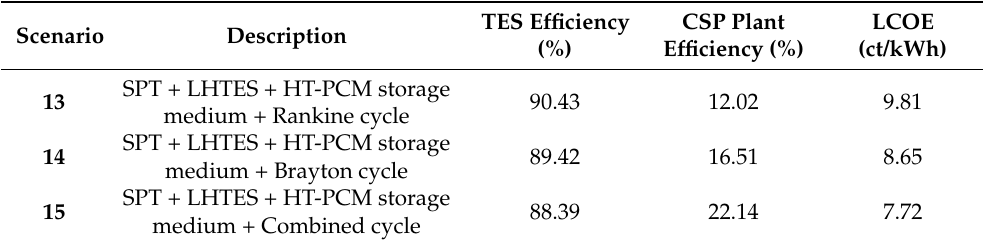
Table 12. Solar power tower plant LCOE analysis for 50 MW installed capacity with regular stor- age medium.